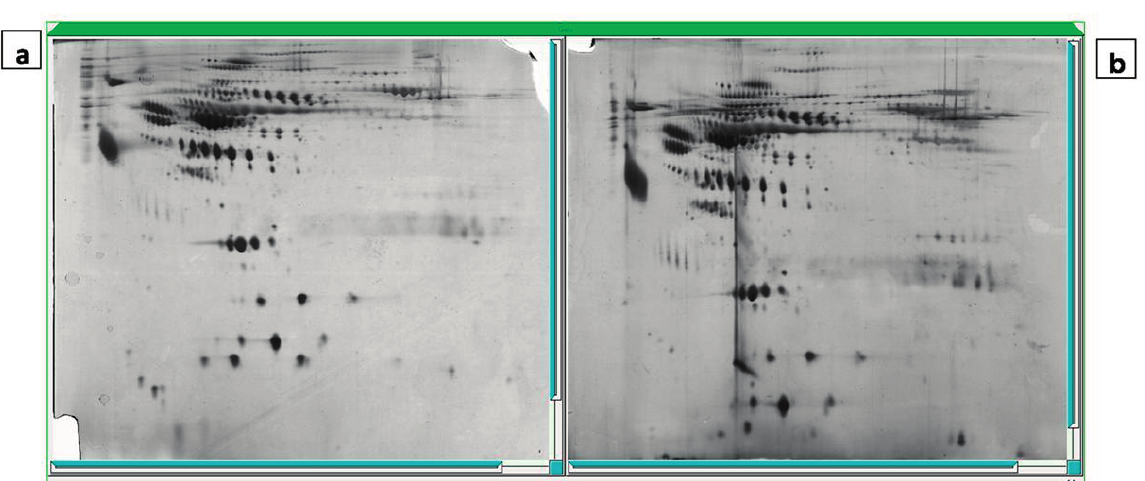
Figure 2. Two-dimensional gel electrophoresis map of young ( a ) and aged groups ( b ) (silver